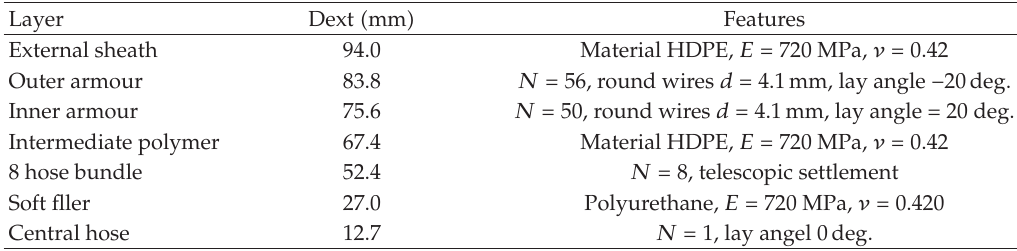
Figure 5: Example of test results compared to analysis and theoretically obtained values. Table 1: Cust´odio and Vaz. umbilical